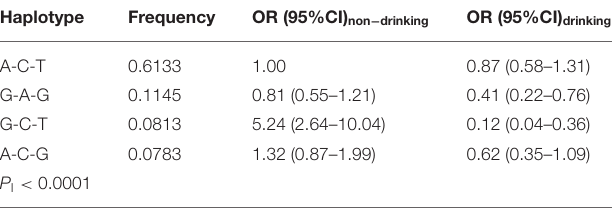
TABLE 8 | Interactions of the haplotypes and smoking on the risk of IS. Haplotype